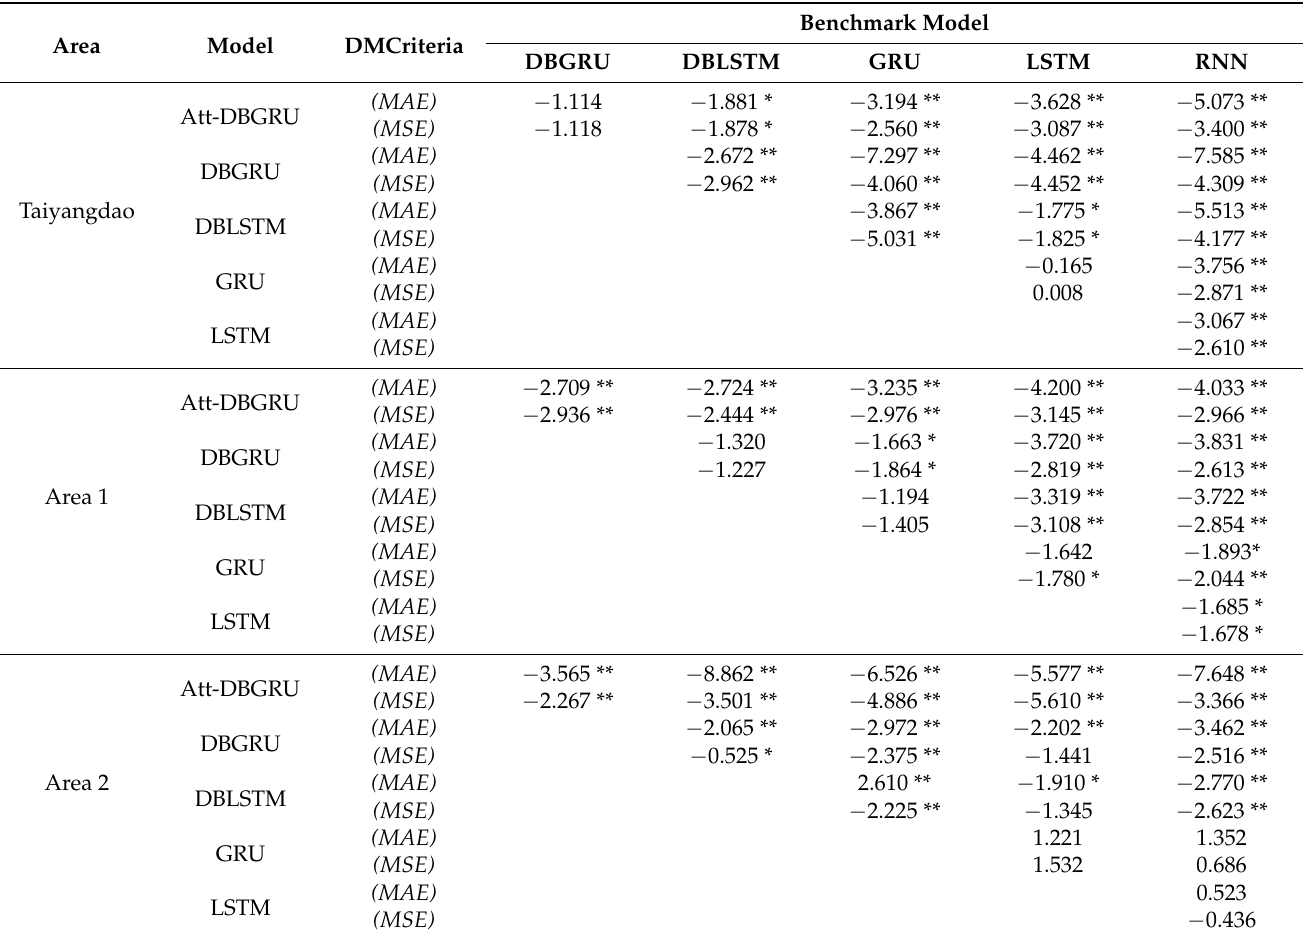
Table 3. Results of Diebold–Mariano